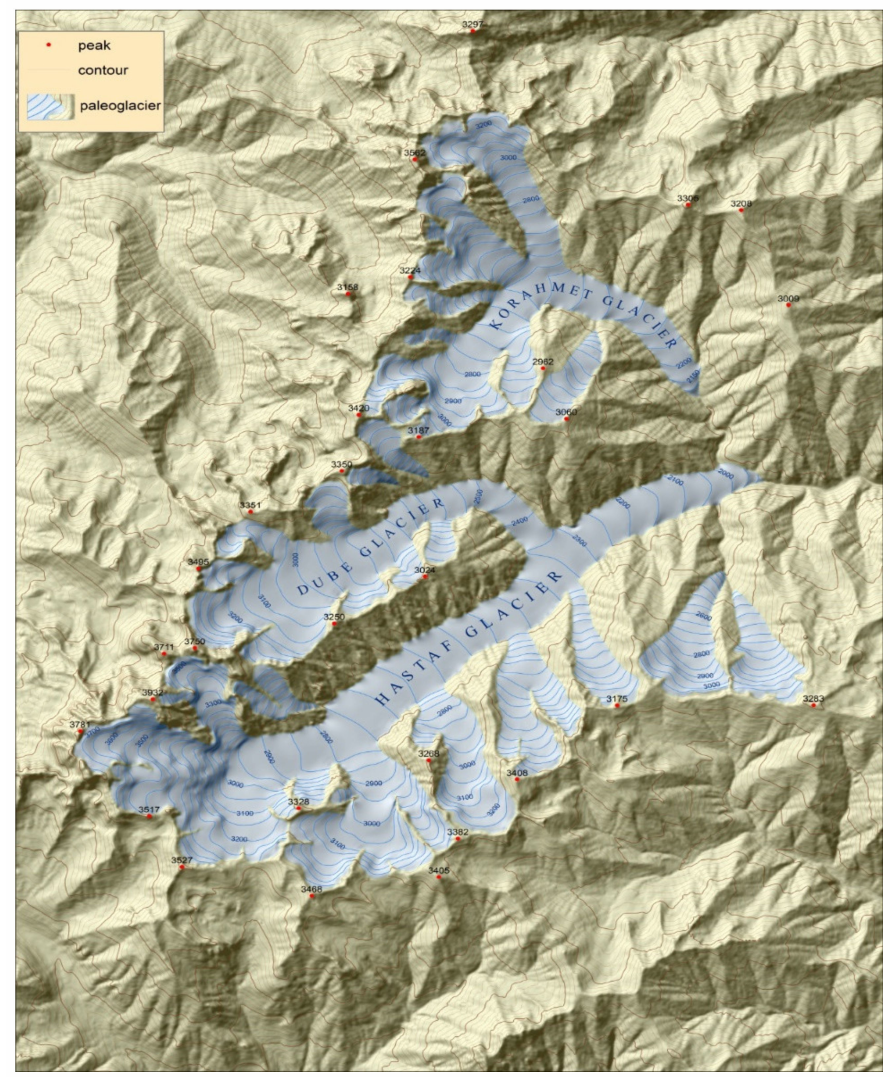
Figure 11. Glacier reconstruction in the Central Çoruh Valley System for the 22.2 ± 2.6 ka advance. The 34 ka advance did not reach the same ice volume in the middle valley sector (Figure 3). Recon- structed maximum ELA is at approx. 2700 m a.s.l. Dübe and Hastaf glaciers merged at Olgunlar (Figure 7, sample TRYAY-11). The Körachmet glacier did not reach the Barhal Valley. The recon- structed ice volume and glacier extension in the uppermost Hastaf Cirque are a first minimum approximation.Due to the Barhal Valley orientation from west to east, there are also several north- facing tributary valleys in the Hastaf Valley beside the main valley and the Dübe branch. The exposition of the tributary valleys and their hypsometry probably played a considerable role in the build-up of the paleoglacier volume. Furthermore, these tributary valleys have the potential to host independent resting cirque glaciers (i.e., not connected to the glacier in the main valley) by an intermediate ELA (Equilibrium Line Altitude) depression, and therefore, they might have still been present when the main valley was ice-free after 18.3 ± 1.7 ka and before 15.6 ± 1.8 ka. The direct comparison of ice-covered area during the LGM of the Barhal Valley (34.4 km 2 ) to the ice-covered area of the opposing Kavron Valley (22 km 2 ) has therefore been considered with caution but still can be counted as a considerable